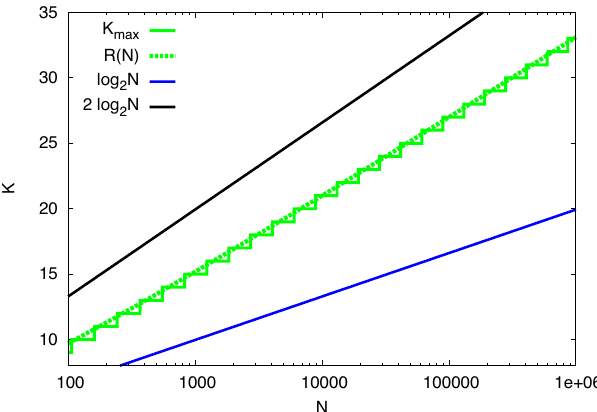
Figure 2. Maximum size of a clique in G ( N , 0.5) as function of the order of the graph. In green are presented K max , result of solving (2) and R ( N ) given by (3), respectively. In black is plotted the value of 2log blue, log 2 N